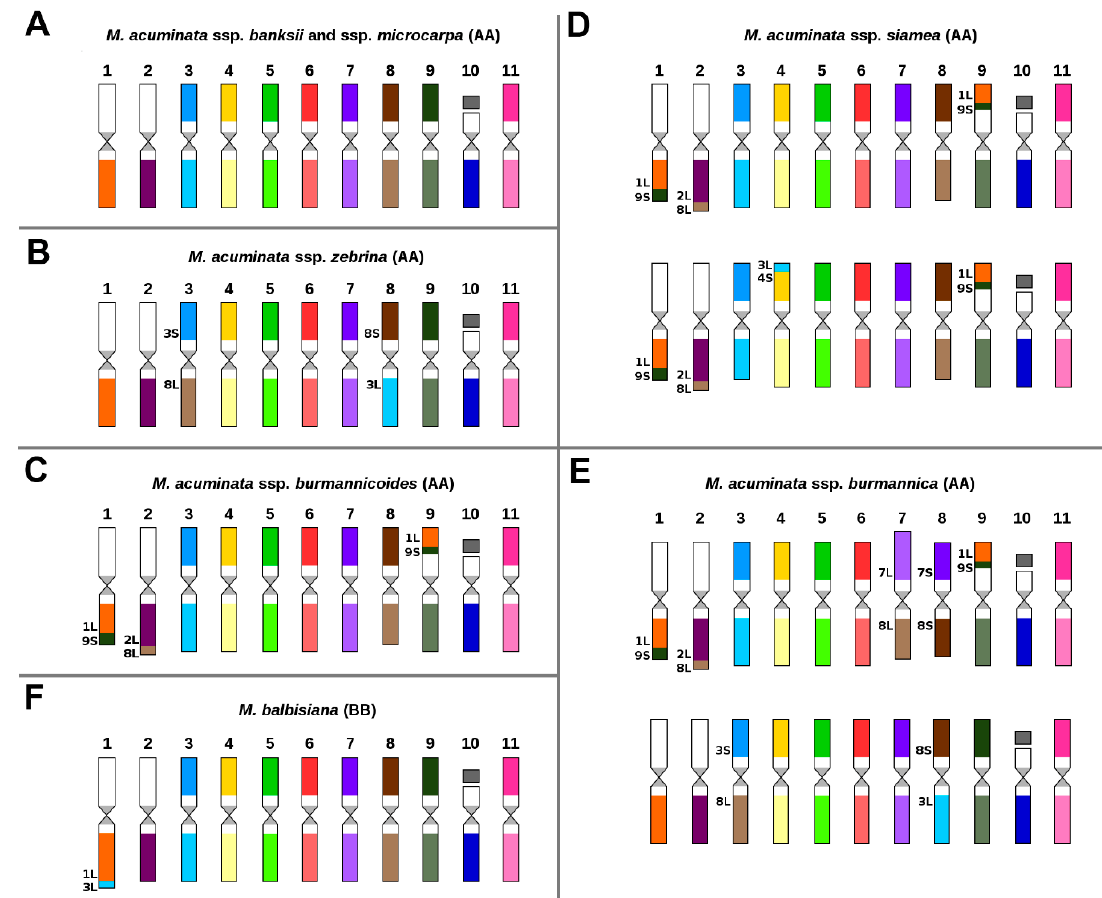
Figure 1. Ideograms of six diploid (2n = 2x = 22) subspecies of Musa acuminata and diploid (2n = 2x = 22) Musa balbisiana : ( A ) M. acuminata ssp. banksii “Banksii” and ssp. microcarpa “Borneo”; ( B ) M. acuminata ssp. zebrina “Maia Oa”; ( C ) M. acuminata ssp. burmannicoides “Calcutta 4”; ( D ) M. acuminata ssp. siamea “Pa Rayong”; ( E ) M. acuminata ssp. burmannica “Tavoy”; ( F ) M. balbisiana “Pisang Klutuk Wulung”. Chromosome paints were not used for the short arms of chromosomes 1, 2, and 10. Chromosomes are oriented with their short arms on top and the long arms on the bottom in all ideograms. For better orientation, translocated parts of the chromosomes contain extra labels, which include chromosome number and the chromosome arm that was involved in the rearrangement.